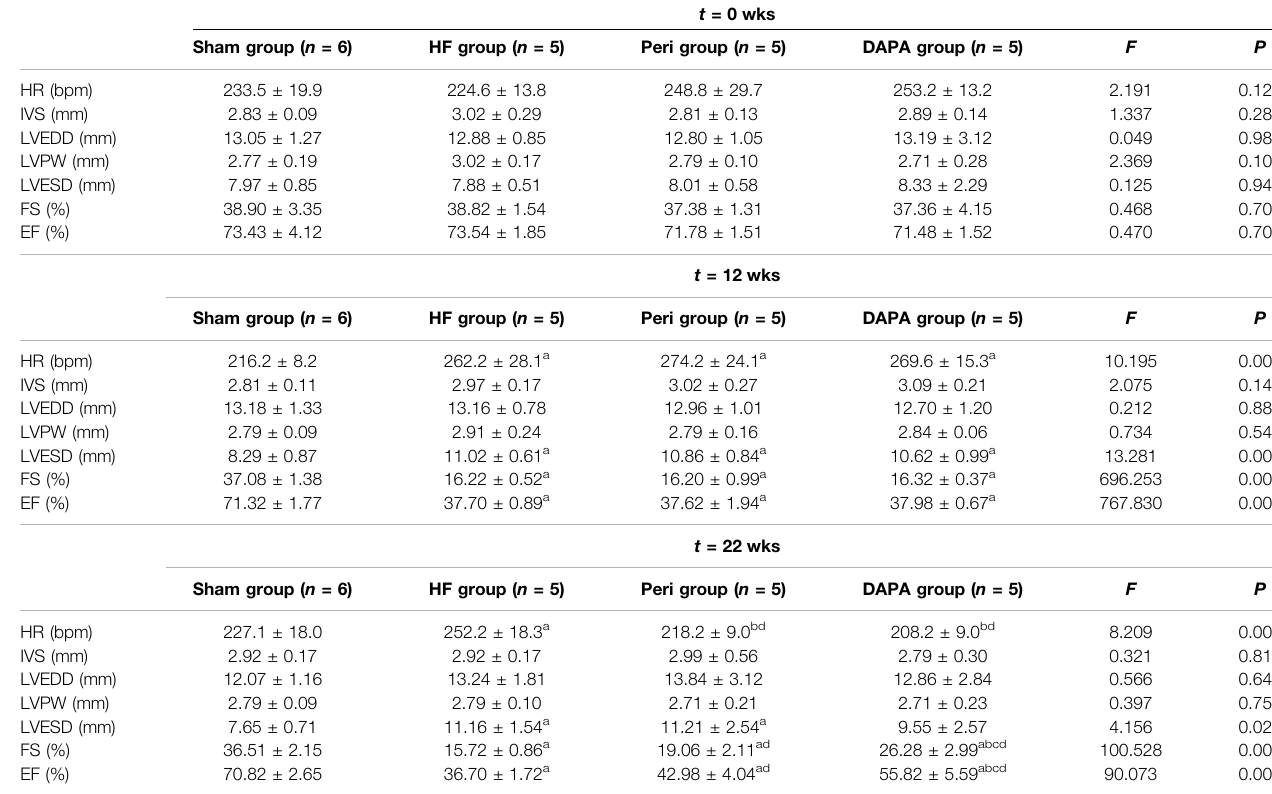
TABLE 2 | Echocardiographic investigation of left ventricle structural and functional data in